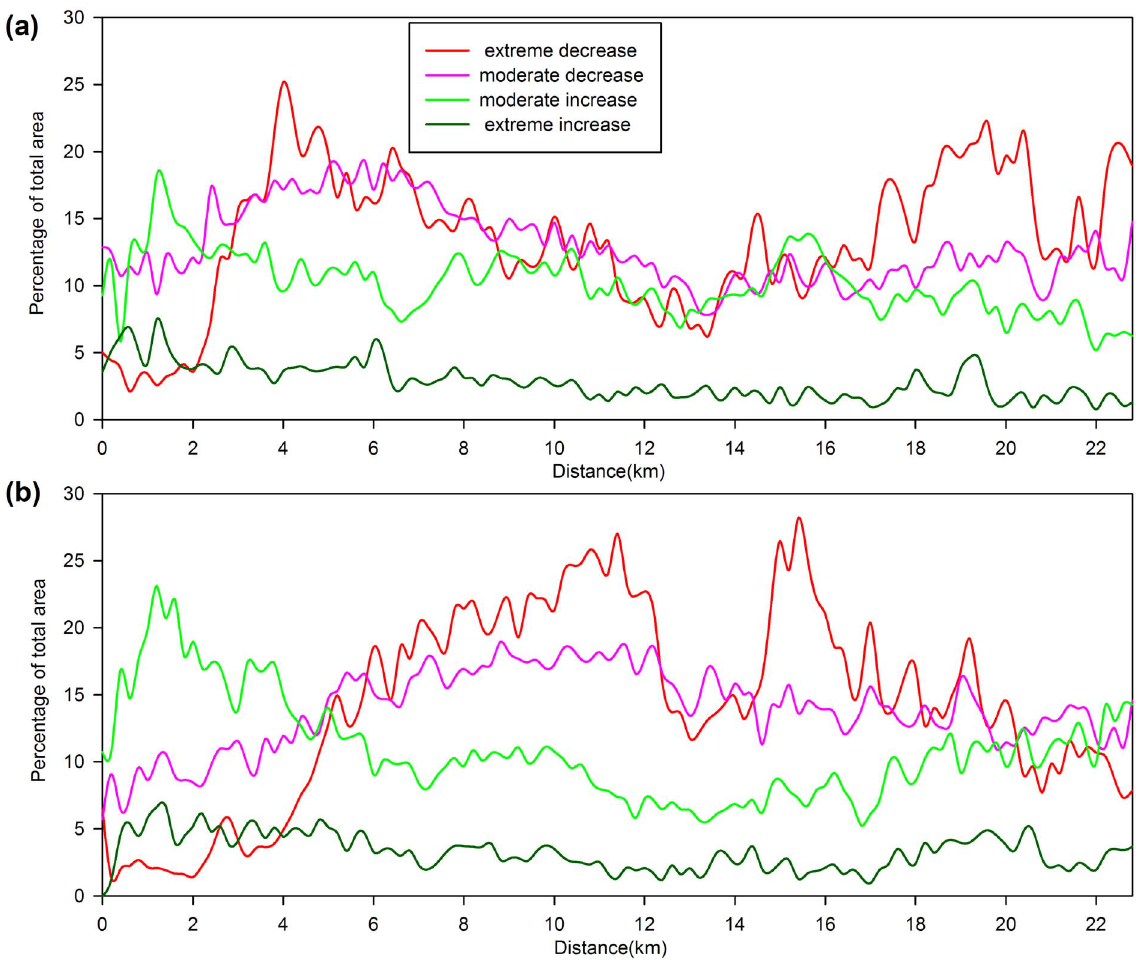
Figure 6. Spatial characteristics of the vegetation fraction change from the urban center over the two periods. (a) 1990–2002 and (b) 2002–2010. The vegetation change categories are shown by the different colors in the legend.